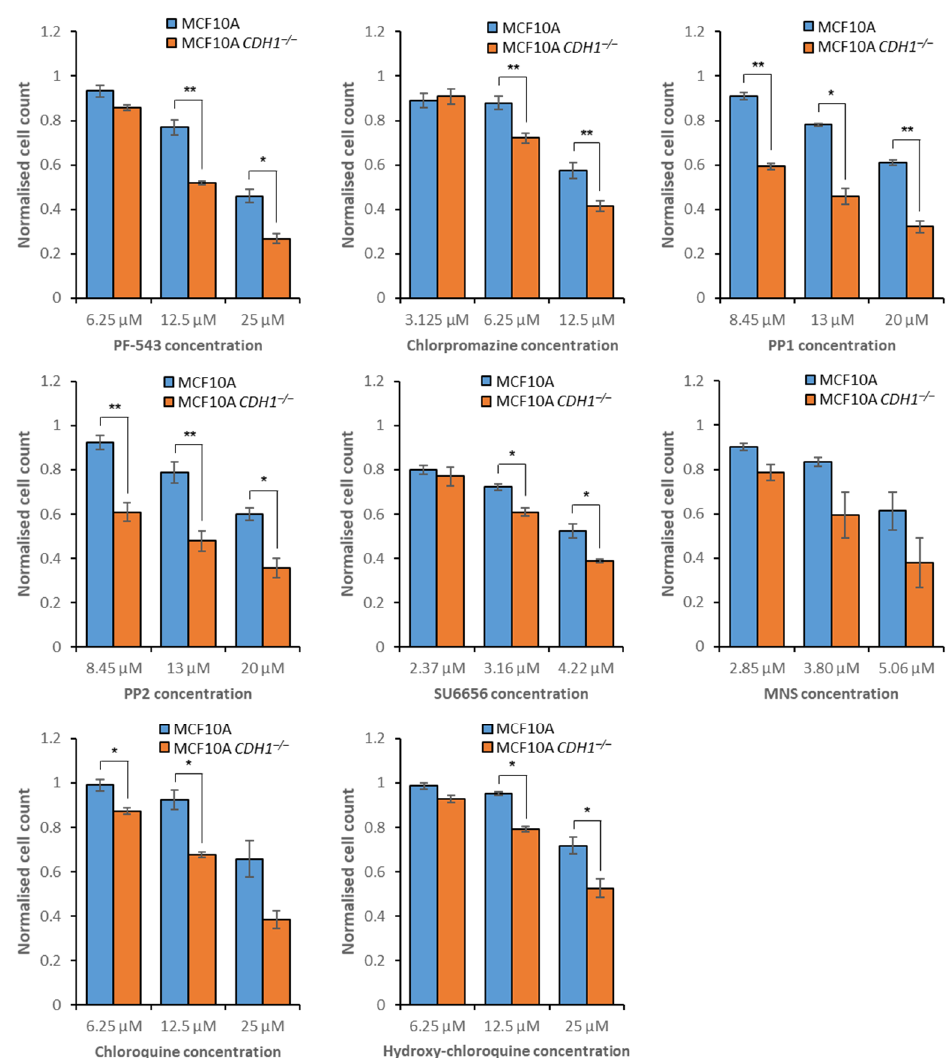
Figure 1. Compounds classified as synthetic lethal from the initial drug screen. MCF10A and MCF10A CDH1 − / − cells were drugged, then viability was quantified through nuclei counting, and normalization to vehicle controls. Although a nine-point serial dilution was assessed, only the three consecutive compound concentrations that exhibited the greatest difference in viability between CDH1 +/+ and CDH1 − / − cells are depicted. MCF10A CDH1 − / − cells were more sensitive to inhibitors of sphingolipid metabolism (PF-543), clathrin-mediated endocytosis (chlorpromazine), flotillin-medi- ated endocytosis (PP1, PP2 and SU6656), vesicle formation (MNS) and autophagy (chloroquine and hydroxy-chloroquine). Average values were calculated from three biological replicates, with +/− 1 standard error of the mean depicted by error bars. P -values were calculated using Student’s t -test; * p < 0.05, ** p < 0.01. MNS: 3,4-Methylenedioxy-β-nitrostyrene.